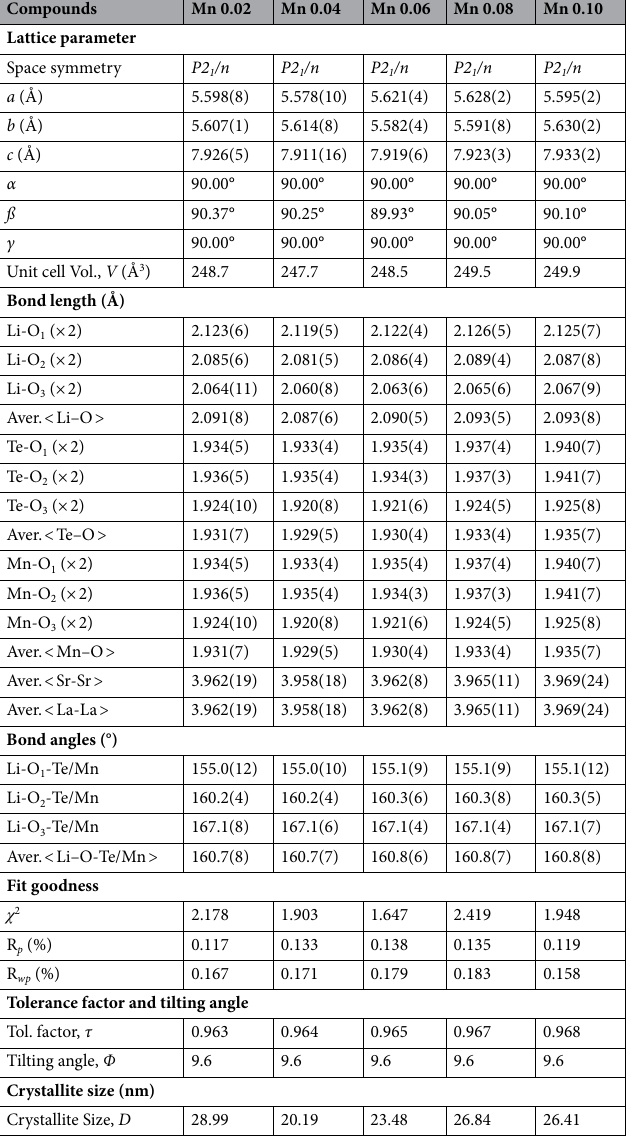
Table 1. Obtained space symmetry, parameters of lattice, V , angles of bonds, lengths of bond, and fit goodness from Rietveld refinement with calculated , τ , and D in SrLaLiTe 1−x Mn x O 6 ϕ